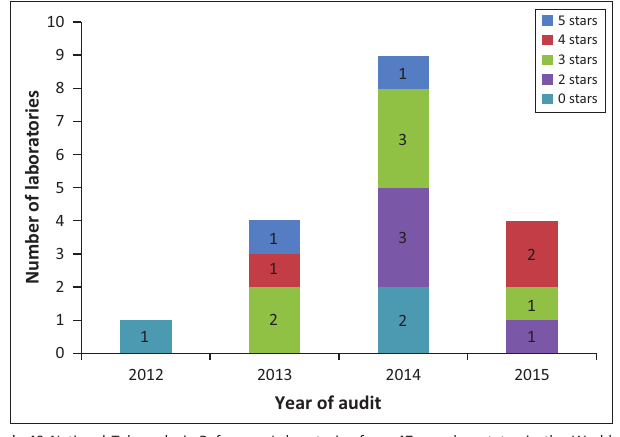
FIGURE 1: Implementation of GLI and SLMTA/TB-SLMTA approaches by National Tuberculosis Reference Laboratories in the World Health Organization’s African Region †